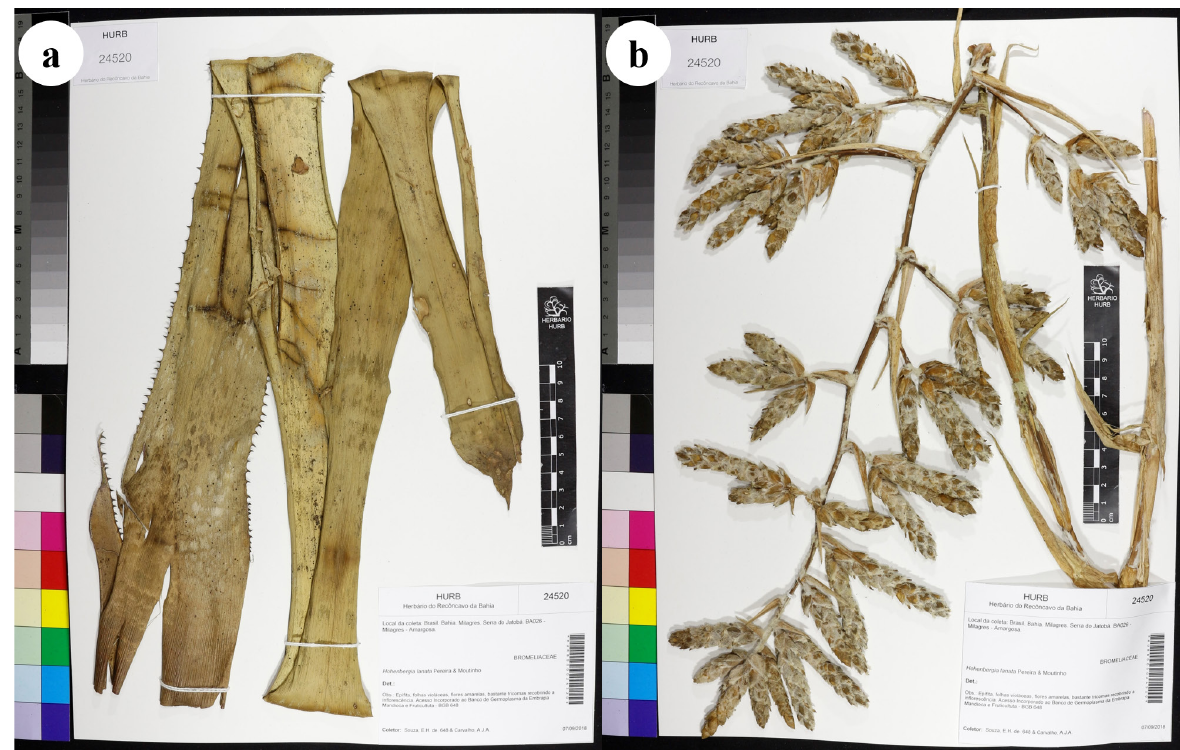
Figure 2. Herbarium specimen (HURB24520) from the recently found population of Hohenbergia lanata Pereira & Moutinho emend. B.P. Cavalcante, E.H. Souza, A.P. Martinelli & L.M. Versieux. a) Leaf. b)